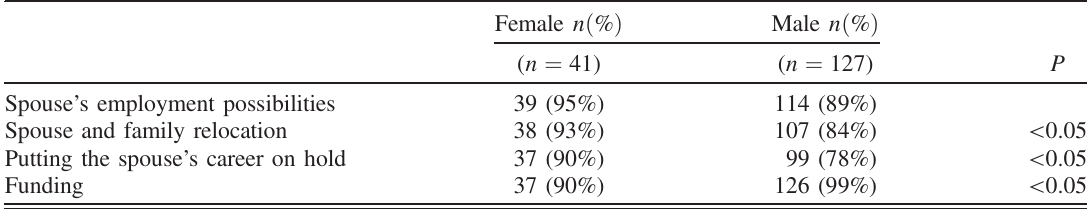
TABLE VII. Survey results on the following question: If you are considering going abroad for a postdoc, how central is this consideration in your decision?